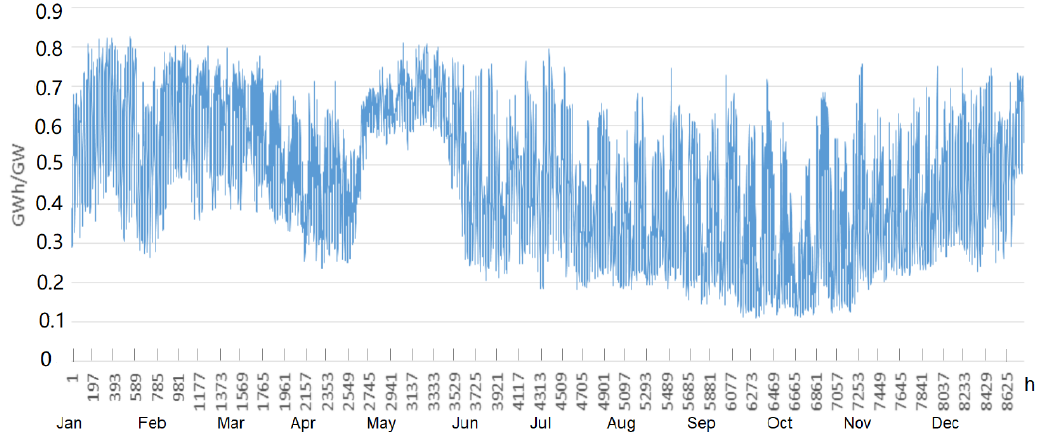
Figure 18. Hourly distribution of hydropower production in Finland.